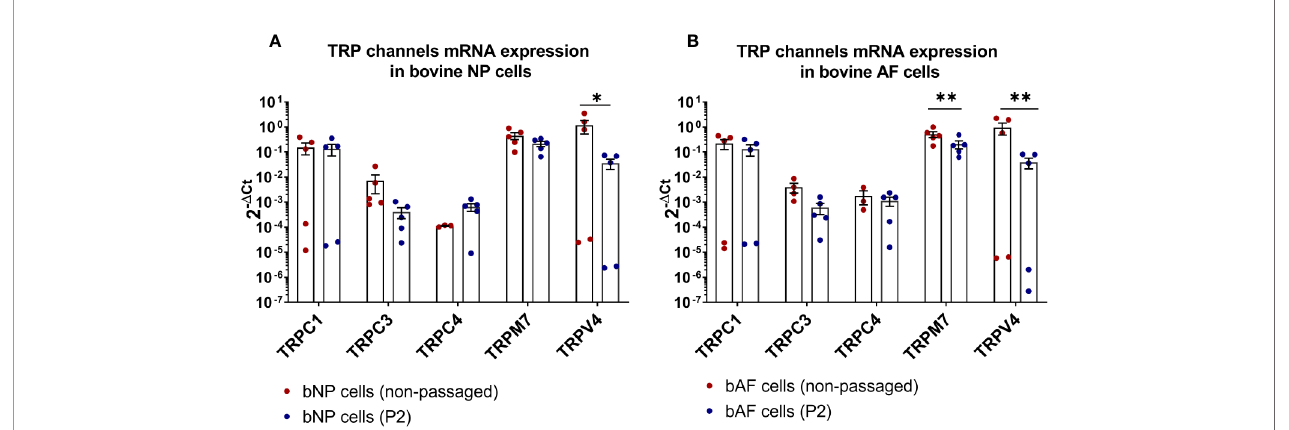
FIGURE 1 | The mRNA expression of TRP channels in (A) bovine nucleus pulposus (bNP) and (B) annulus fi brosus (bAF) cells obtained directly after cell isolation (non-passaged) or cells passaged until passage 2 (P2). Graphs show 2 − D Ct values relative to YWHAZ (mean ± SEM, n = 5). Asterisks indicate statistical signi fi cance (*p < 0.05, **p < 0.01) between non-passaged and passaged cells.